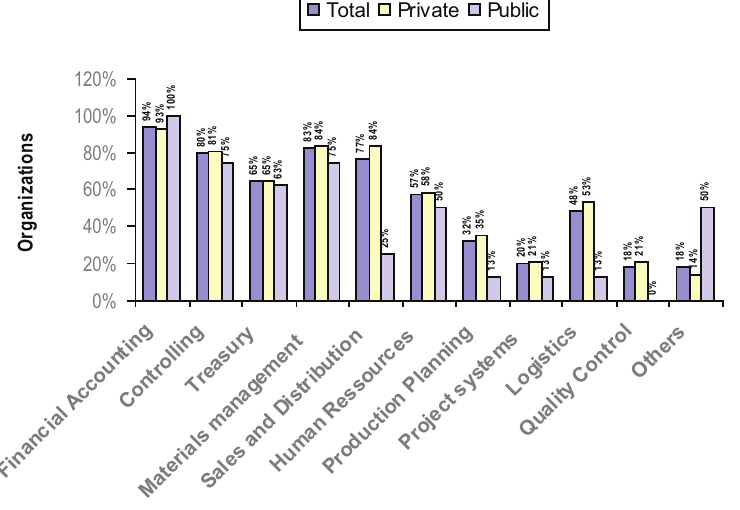
Fig. 1. ERP Modules implemented in Portuguese public/private organizations The public sector respondents have been using ERP systems for over 3 years and less than 9 years. In the private sector the majority of respondents have been using ERP systems for more than 5 years (Table 4). However, the differences between private and public organizations are not statistically significant (Table